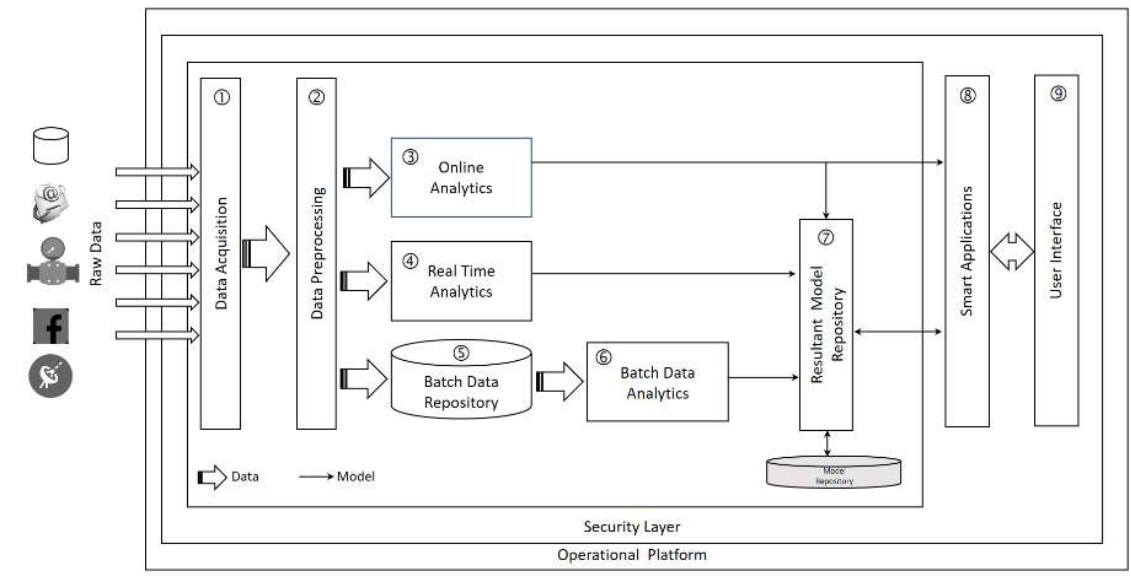
Figure 15. Modified SCDAP conceptual design.